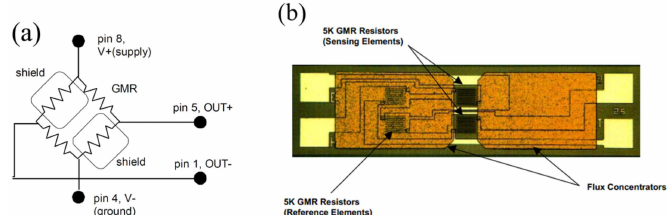
Figure 5. ( a ) NVE AA003-02E GMR sensor functional block diagram; ( b ) photomicrograph of an NVE sensor element